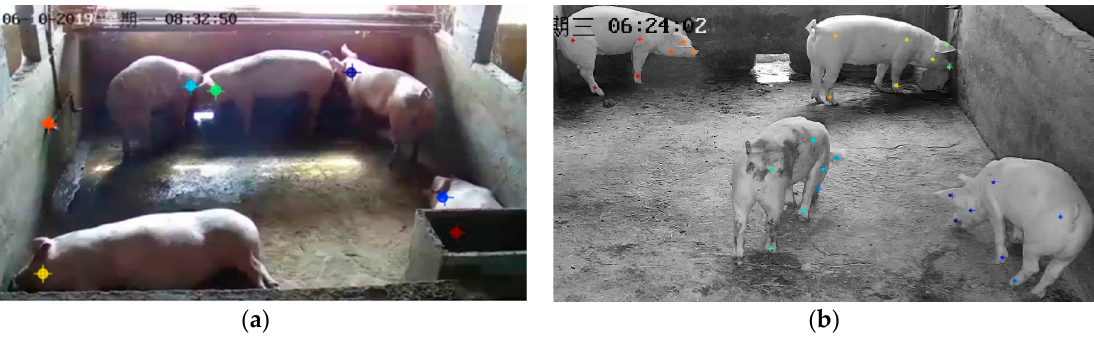
Figure 8. Results of generalization training. “+++++” is a manual marker, and “ ” represents the tracking results after training. ( a ) Tracking results of 7 targets; ( b ) tracking results of 28 targets.